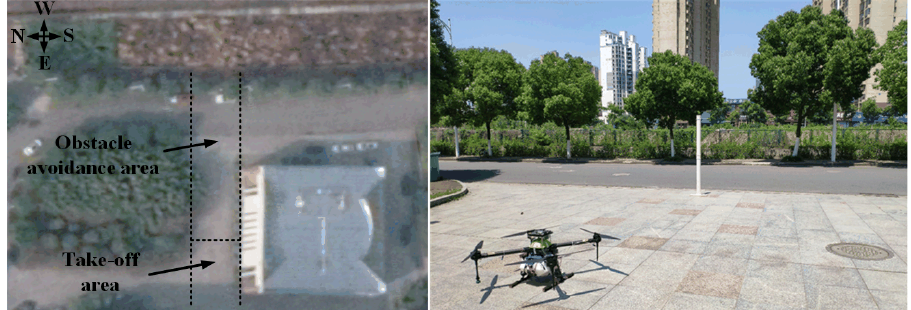
Figure 6. Experimental area.